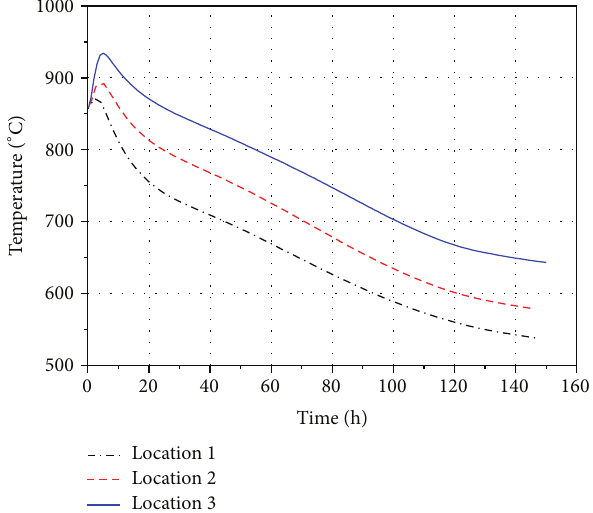
Figure 7: The temperature of locations 1, 2, and 3 versus time.